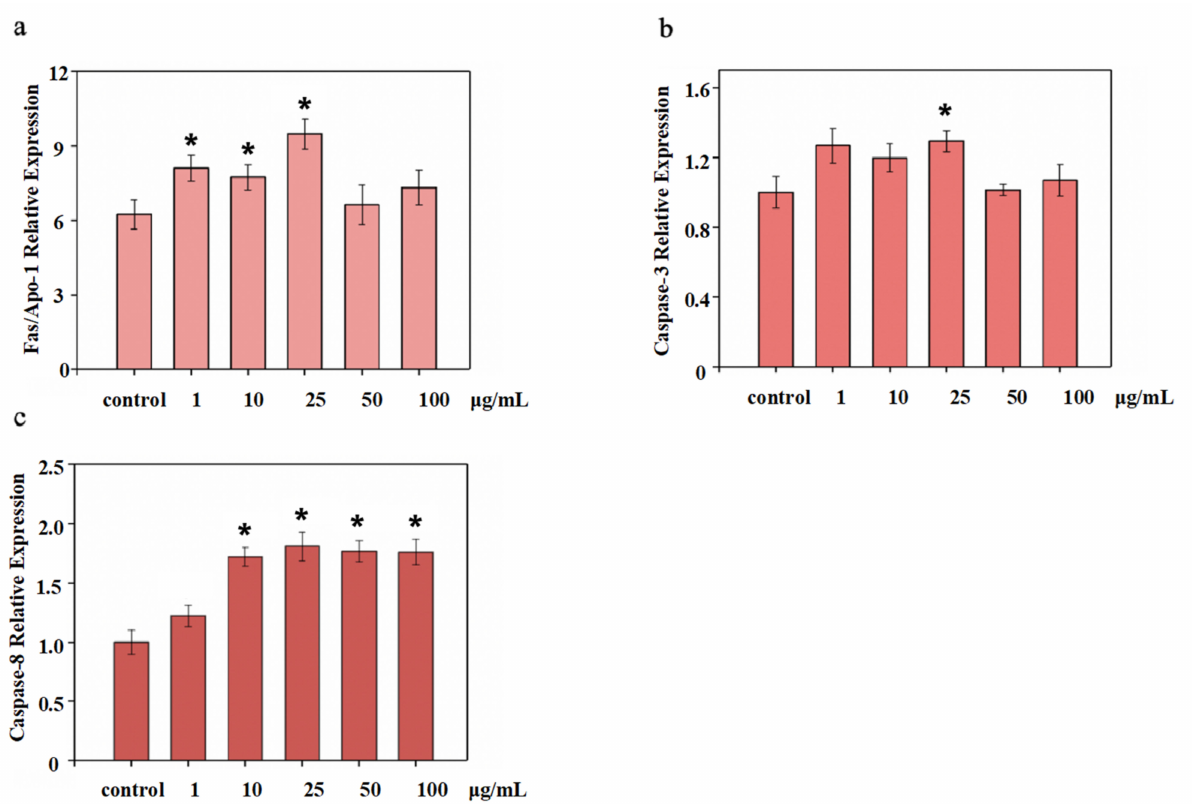
Figure 9. Gene expression of CD8 + T cells by real-time PCR treated with varying concentrations of NTCII. ( a ) Fas/Apo-1; ( b ) Caspase-3; ( c ) Caspase-8. (Shapiro-Wilk value > 0.05, using one-way ANOVA and Dunnette for post hoc tests.) An asterisk indicates that there is a significant difference compared with the control group (* p <